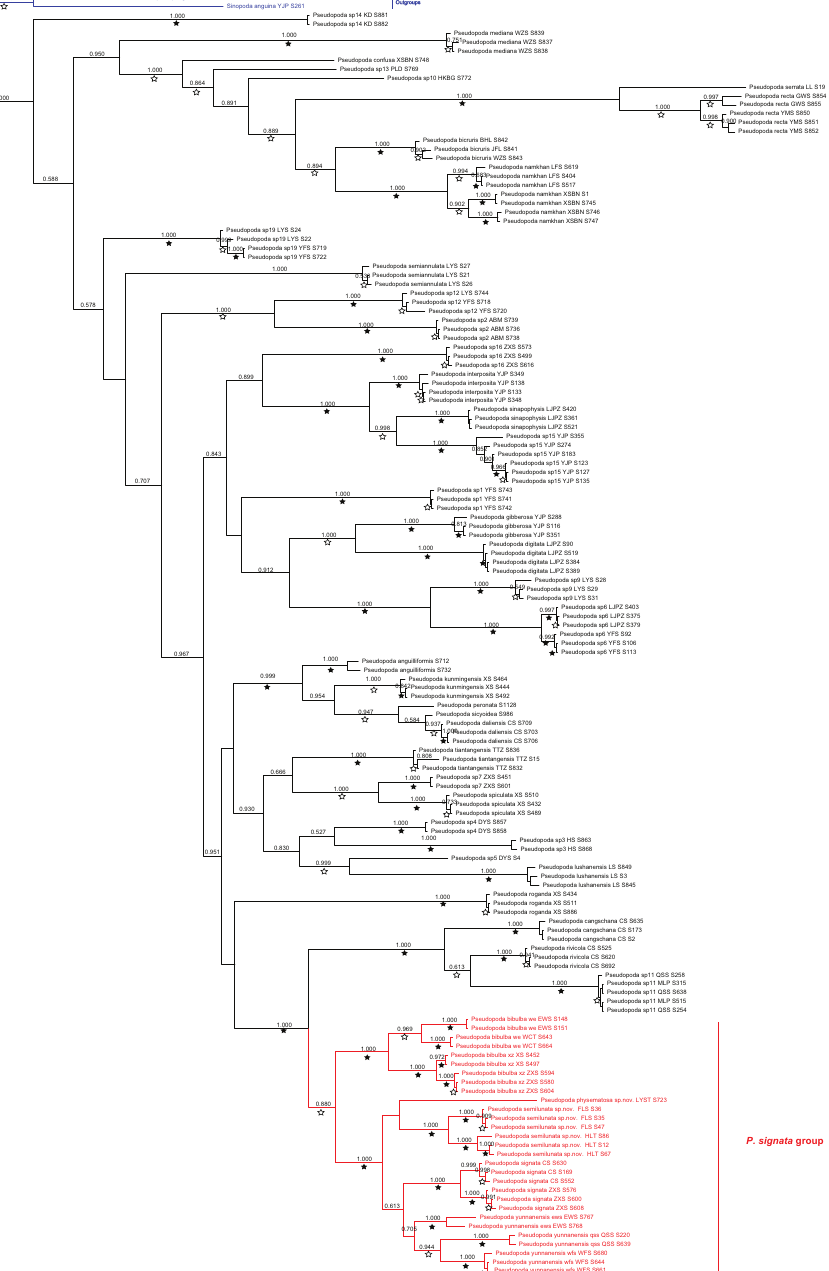
Figure 1. Bayesian tree based on the COI + ITS2 dataset including 144 Pseudopoda individuals belong- ing to 44 species. Numbers on nodes are posterior probabilities; bootstrap support from ML analyses is indicated as solid stars for values > 95%, open stars > 50–95%. Red clade indicates the P. signata group, blue clade indicates the outgroups. Phylogenetic tree cited from Zhang et al.